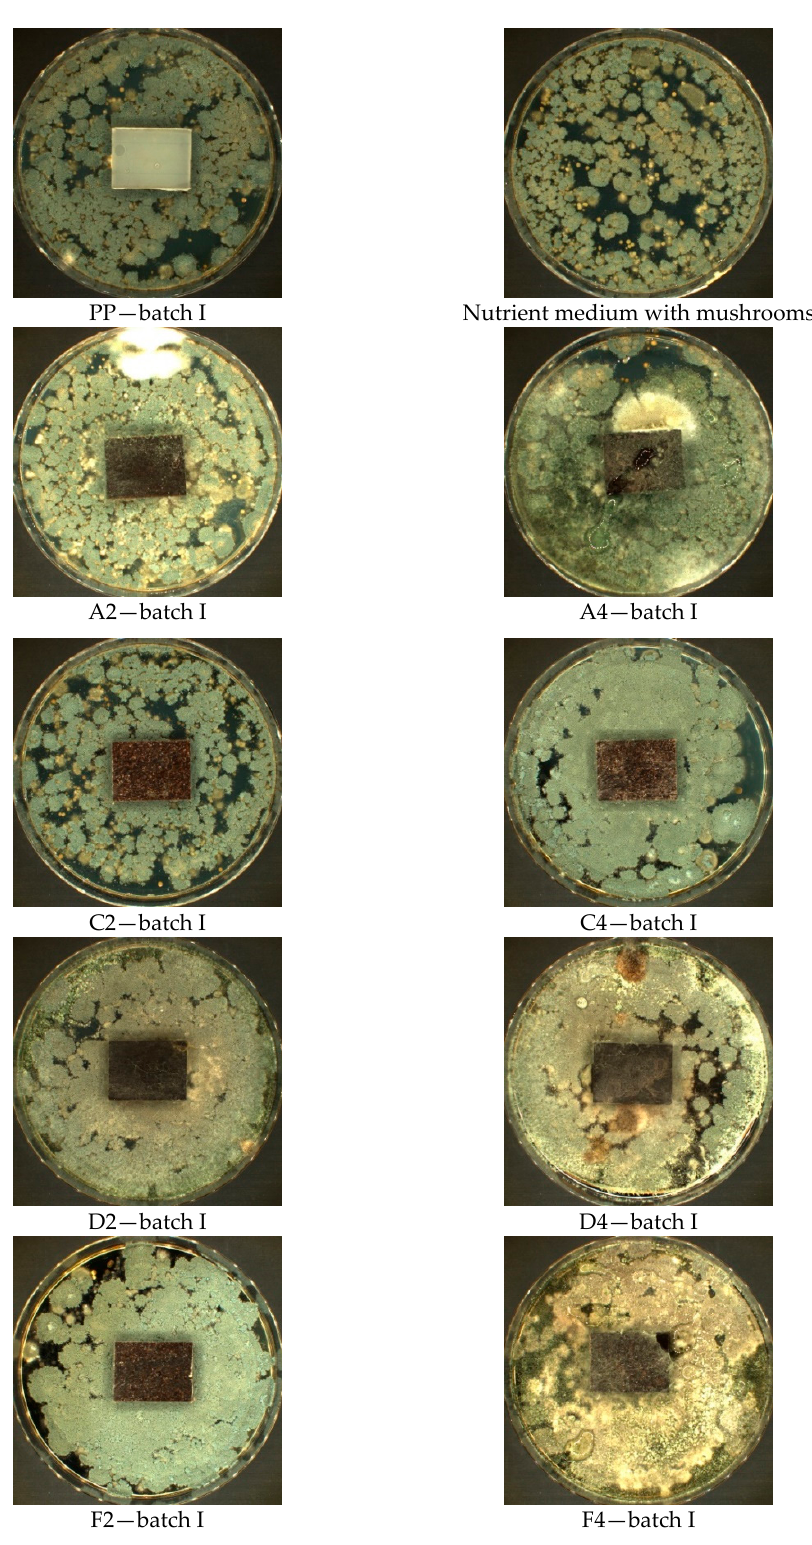
Figure 4. Method B—results of visual assessment of samples; photos of batch samples: I.